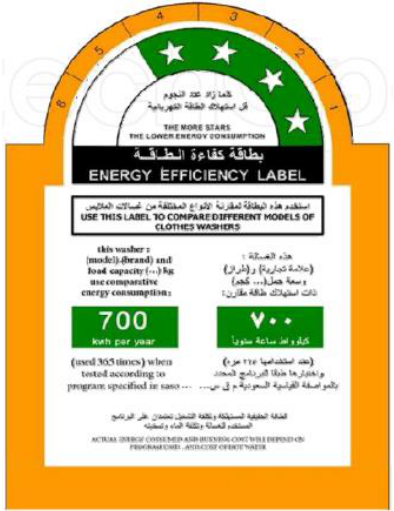
Figure 1. Sample energy efficiency label adapted from [48].